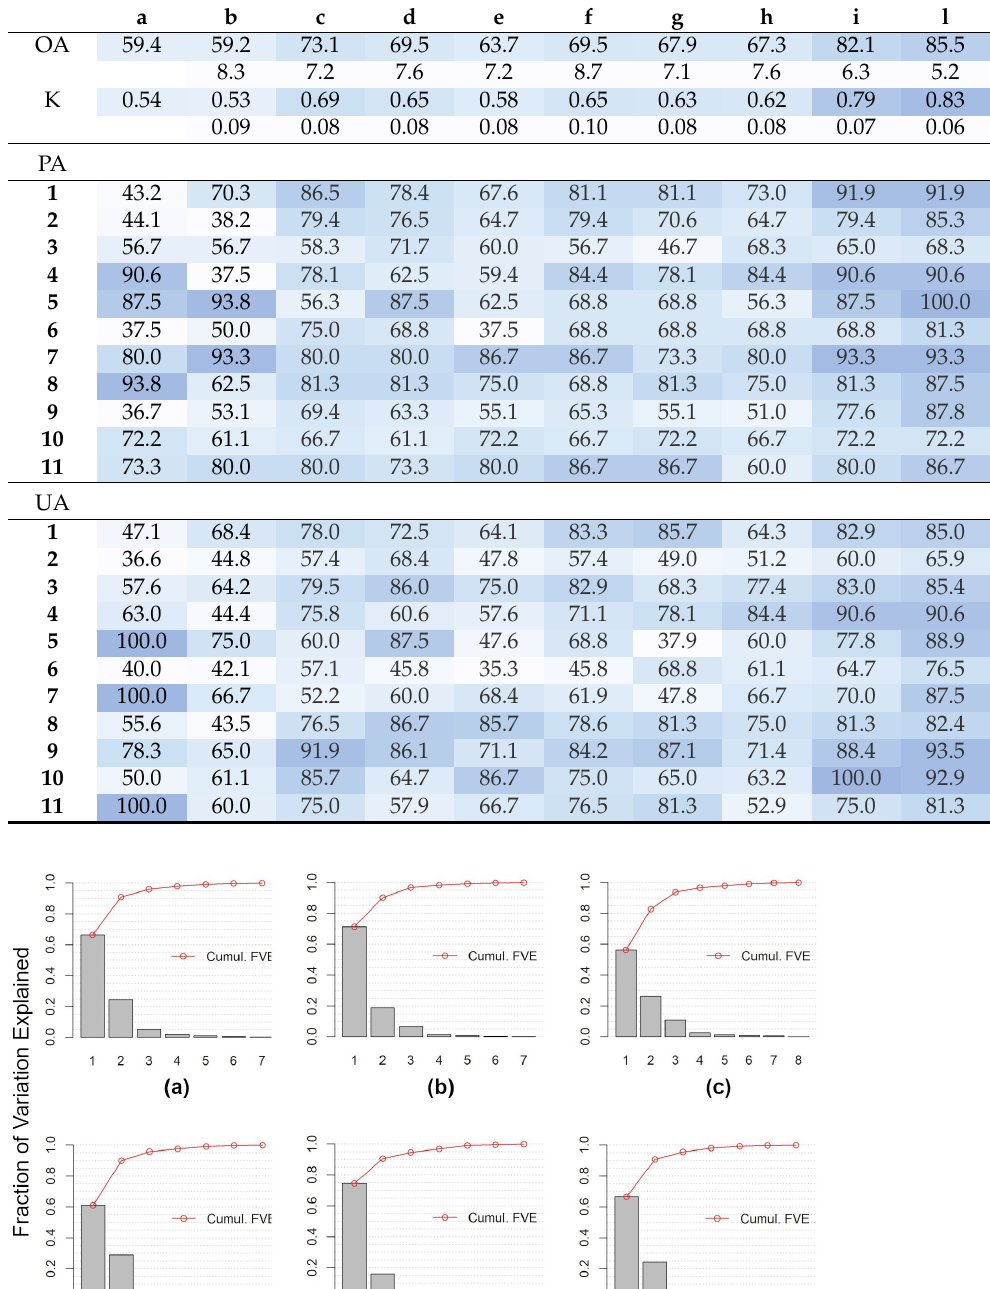
Table A1. Comparison of performance (OA, K, UA, and PA) between traditional map (a) and models based on components: (b) topography, (c) NDVI, (d) GNDVI, (e) MCARI, (f) NDRE, (g) NDWI, (h) MNDWI, (i) all time-series, and (l) all time-series + topography. Legend numbers correspond to plant associations and habitats listed in Table 1.